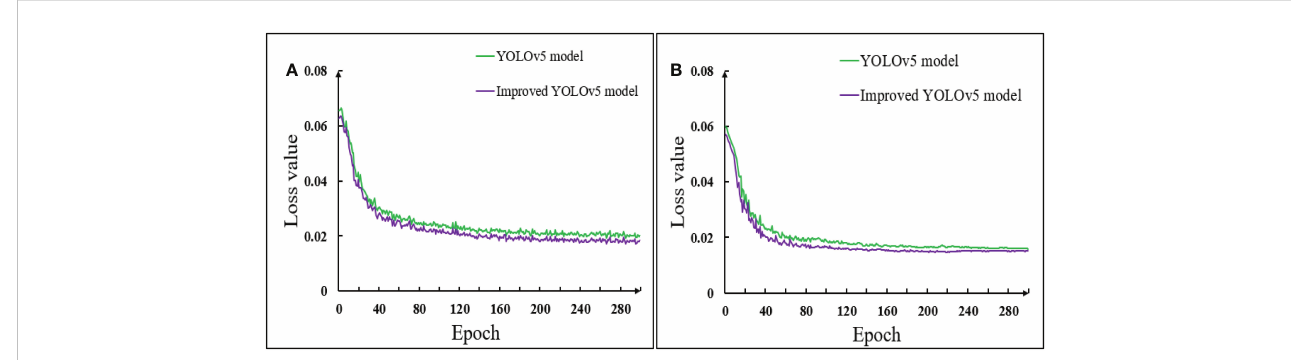
FIGURE 10 Comparison of loss function of model before and after improvement (A) Training set; (B) Validation